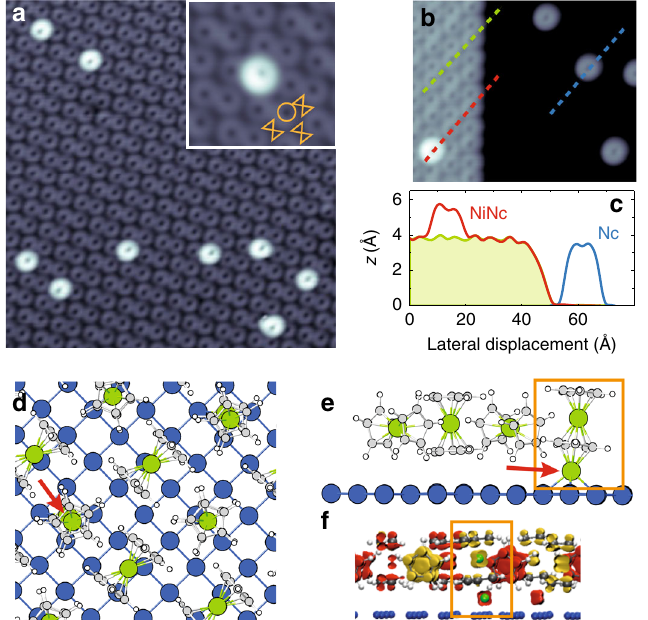
Fig. 1 NiNc adsorption in a nickelocene layer. a Self-assembled layer (paired con fi guration) and NiNc complex on Cu(100) (image size: 16 × 16 nm 2 , sample bias: 20 mV, tunneling current: 20 pA). Inset: Close-up view of a NiNc complex in the paired layer. The molecular arrangement is sketched in orange as a circle for the vertical Nc and as a hourglass for the horizontal Nc (4 × 4 nm 2 , 20 mV, 100 pA). b Edge of a paired layer and isolated Nc molecules on Cu(100) (10 × 10 nm 2 , 20 mV, 100 pA) and c their corresponding height pro fi les along the dashed lines in b . d Top view, e side view of the DFT optimized structure of the NiNc complex embedded in a Nc paired layer — some molecules have been removed for clarity (H: white, C: gray, Ni: green). The red arrow indicates the position of the Ni adatom. f Side view of the spin density map of the paired structure containing two Ni atoms. Orange rectangles mark the NiNc complex. Yellow: Spin up, red: Spin